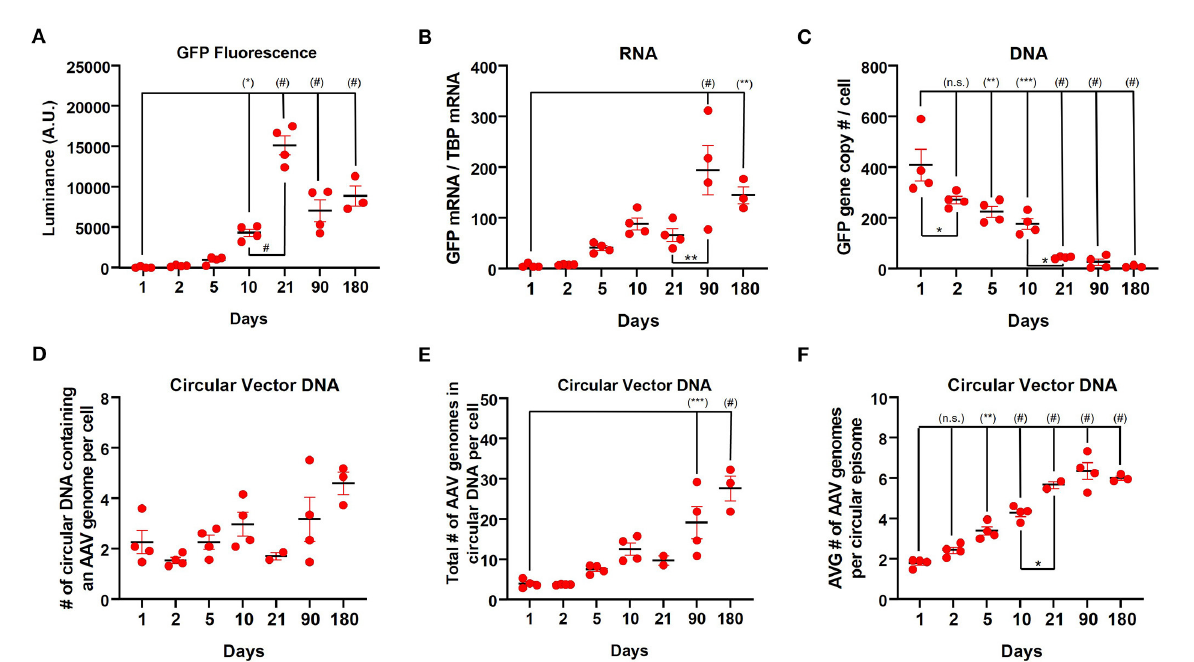
FIGURE4 Long-term kinetics of rAAV9-CAG-GFP in the striatum in mice. (A) Quantification of luminance from native GFP fluorescence (500ms exposure) during the first 6 months after rAAV9-CAG-GFP administration. (B) ddPCR analysis measuring the amount of GFP mRNA relative to TBP mRNA and (C) GFP DNA copies per cell as determined by copy numbers of GFP to two glucagon copies per cell during the first 6 months after administration of rAAV9-CAG-GFP. Data from 3 weeks, 3 and 6 months was previously presented in Figure 2. (D) The number of circular DNA units that contain an AAV genome (not considering concatemers) per cell, (E) the total number of AAV genomes in circular DNA per cell (diploid genome) and (F) the average number of AAV genomes per circular episome [values from (E) divided by values from (D) ] in the striatum of mice during the first 6 months after administration of rAAV9-CAG-GFP. Data was analyzed using a one-way ANOVA followed by Tukey’s multiple comparisons test. * p < 0.05, ** p < 0.01, *** p < 0.001, and # p < 0.0001. Significance symbols in parentheses are compare with day